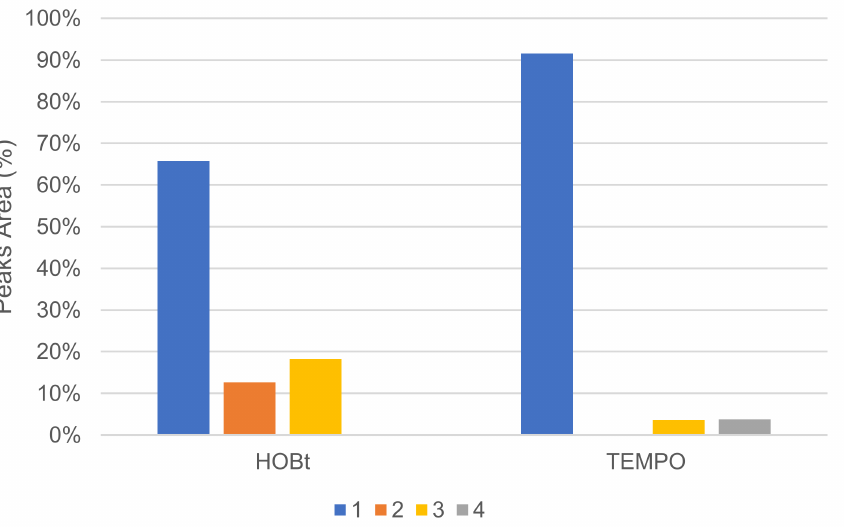
Figure 9. Comparison of oxidation products using HOBt or TEMPO as %area in the crude product determined by GC/MS (LA 10% w/w , mediator 50 mol%, acetate buffer pH5 0.25 M, O 2 atmosphere, incubation for 24 h, 40 ◦ C, 200